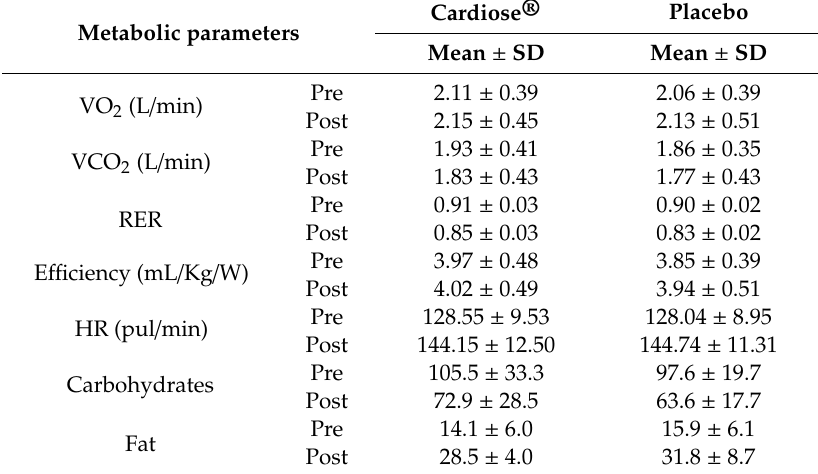
Table 3. Metabolic parameters in VT1 stage before and after the repeated sprint test. Metabolic